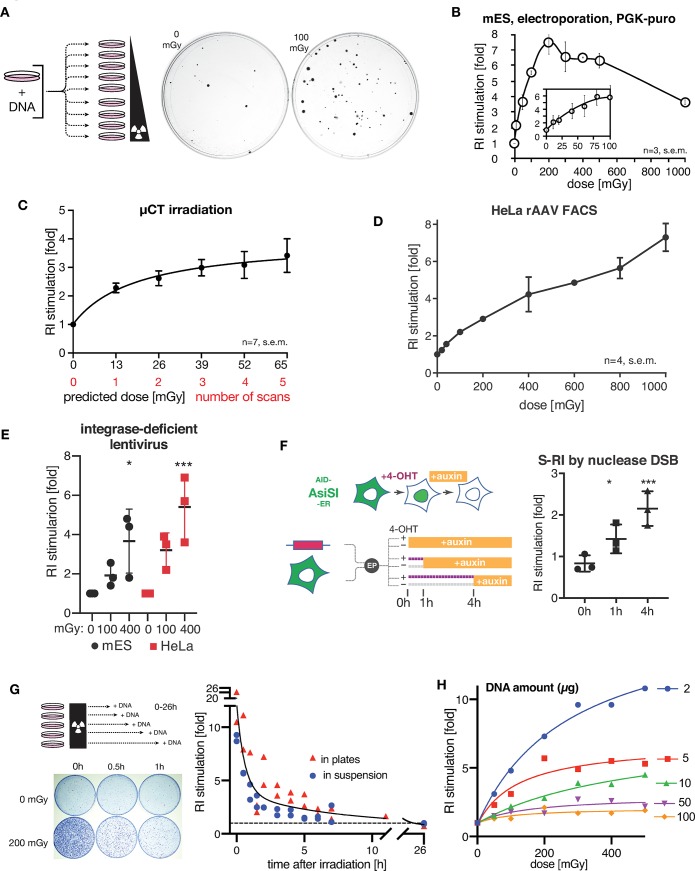
RI is strongly stimulated by low doses of ionizing radiation.(A) Scheme of the typical S-RI assay, in which antibiotic-resistant colony formation is used as an end point. Cells are transfected with linear or circular plasmid DNA, divided over a series of dishes and irradiated with different doses. After 6–8 days of antibiotic selection, plates are stained and colonies counted. Representative examples of an unirradiated plate and a plate irradiated with 100 mGy are shown at the right. (B) Mouse ES cells were electroporated with linearized plasmid with puromycin resistance gene. Colony numbers were normalized to unirradiated control to give the fold increase in RI efficiency, which is plotted. (C) mES cells were electroporated with linear or circular pLPL plasmid, divided evenly into 6 vessels, and subjected to the indicated number of low-resolution micro-CT scans in a Quantum FX instrument. Indicated doses are based on manufacturer’s specification. n = 7, error bars show s.e.m. (D) S-RI in HeLa cells infected with rAAV2-GFP and irradiated with the indicated doses one day later. Cells were maintained without selection, passaged when they reached confluency and sampled by FACS up to day 14. Representative FACS plots are shown in (S1C Fig). The fraction of GFP positive cells in irradiated cultures normalized to unirradiated control is plotted. (E) S-RI in mES and HeLa cells infected with IDLV carrying puromycin-resistance gene and irradiated with the indicated doses. Ratio of colony numbers in irradiated to unirradiated plates determined in each experiment is plotted. Statistical significance indicated by asterisks was determined by ANOVA: * p≤0.05, *** p≤0.001. (F) S-RI by nuclease DSB. AID-AsiSI-ER U2OS cells containing a stably integrated coding sequence for AsiSI nuclease tagged with auxin-inducible degron (AID) and estrogen receptor (ER) domain that triggers re-localization from cytoplasm to the nucleus upon addition of tamoxifen (4-OHT). Cells were electroporated with linearized plasmid PGK-puro DNA and seeded immediately into dishes containing either 0 or 300 nM 4-OHT. Auxin was added at the indicated time points to induce AsiSI degradation. The ratio of puromycin resistant colony numbers formed in plates that contained 300 nM 4-OHT was divided by the number of colonies in 0 nM plates. Statistical significance indicated by asterisks was determined by ANOVA: * p≤0.05, *** p≤0.001. (G) RI stimulation by irradiation of mES cells before transfection with linearized PGK-puro plasmid. Cells were irradiated either in plates (as shown on the scheme on the left) or in suspension. Data from four independent experiments is plotted. (H) Effect of the amount of transfected DNA on S-RI efficiency determined using colony-formation S-RI assay.